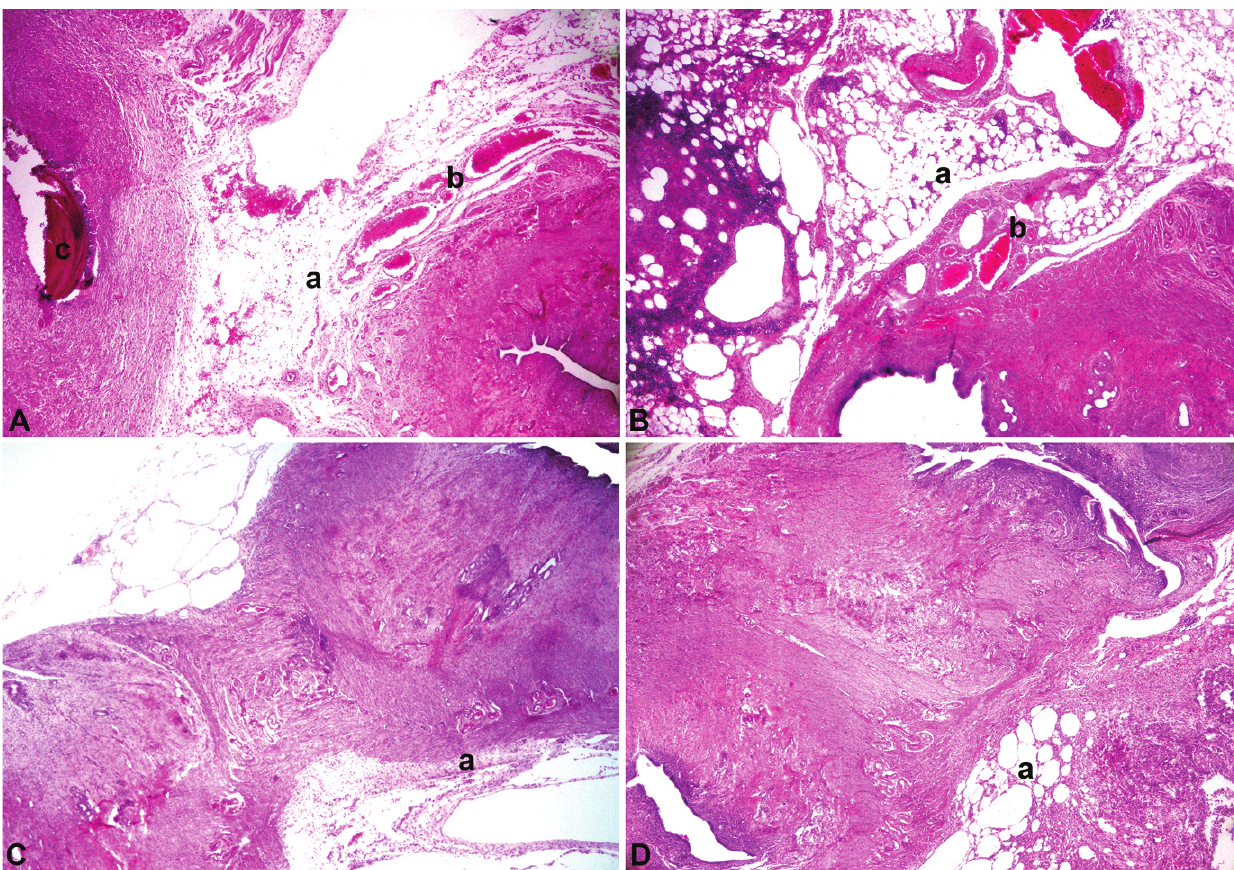
Figure 1 - ( A ) Histopathological view of uterus section in the control group. a) Edema and thickness in serosa, b) capillary vascular proliferation, c) microabscess (H&E, 100 x). ( B ) Histopathological view of uterus section in the vitamin E-treated group. a) Edema and thickness on serosa, b) capillary vascular proliferation (H&E, 100 x). ( C ) Histopathological view of a uterus section in the selenium- treated group. a) Edema on serosa (H&E, 100 x). ( D ) Histopathological view of uterus section in the animals treated with both vitamin E and selenium. a) Edema and thickness on serosa (H&E,